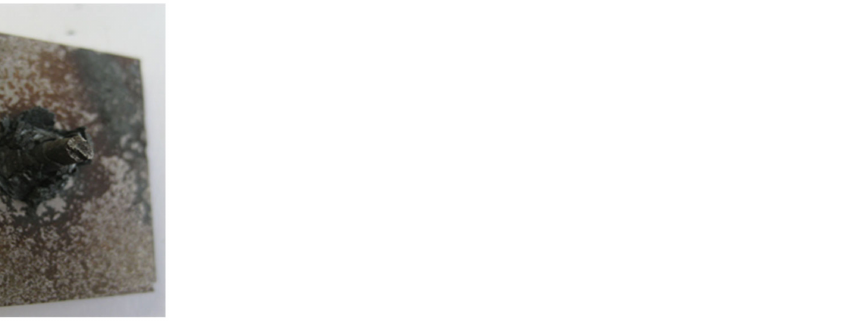
Figure 13. Photo of the Fe3Al intermetal sample after exposure in the boiler combustion